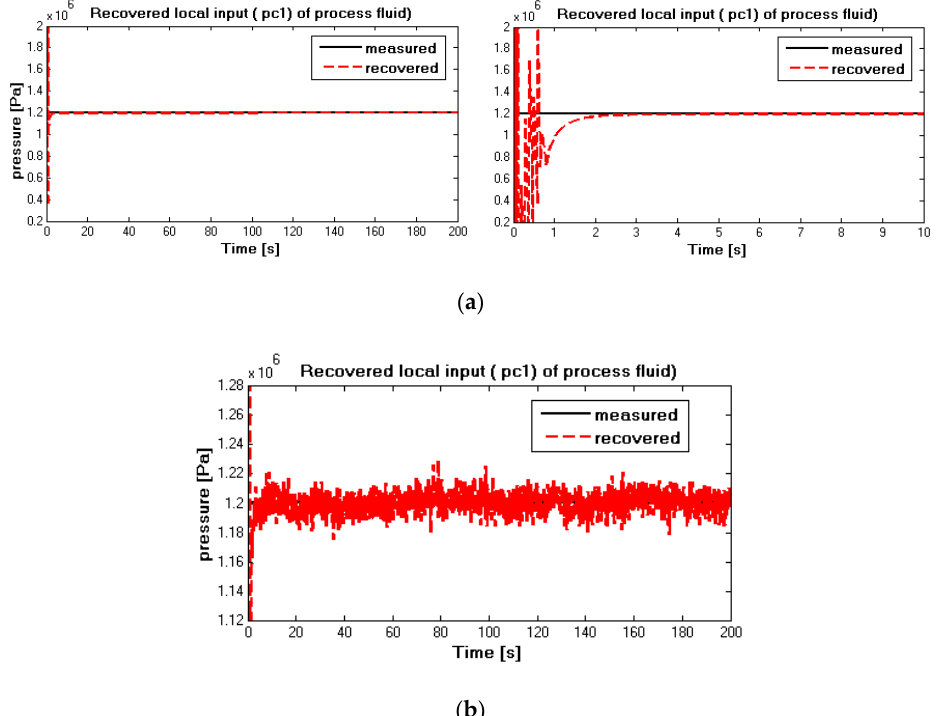
Figure 8. ( a ) Measured and recovered p c 1 (noise-free situation) in case 1; ( b ) measured and recovered p c 1 (noise-corrupted situation) in case 1.